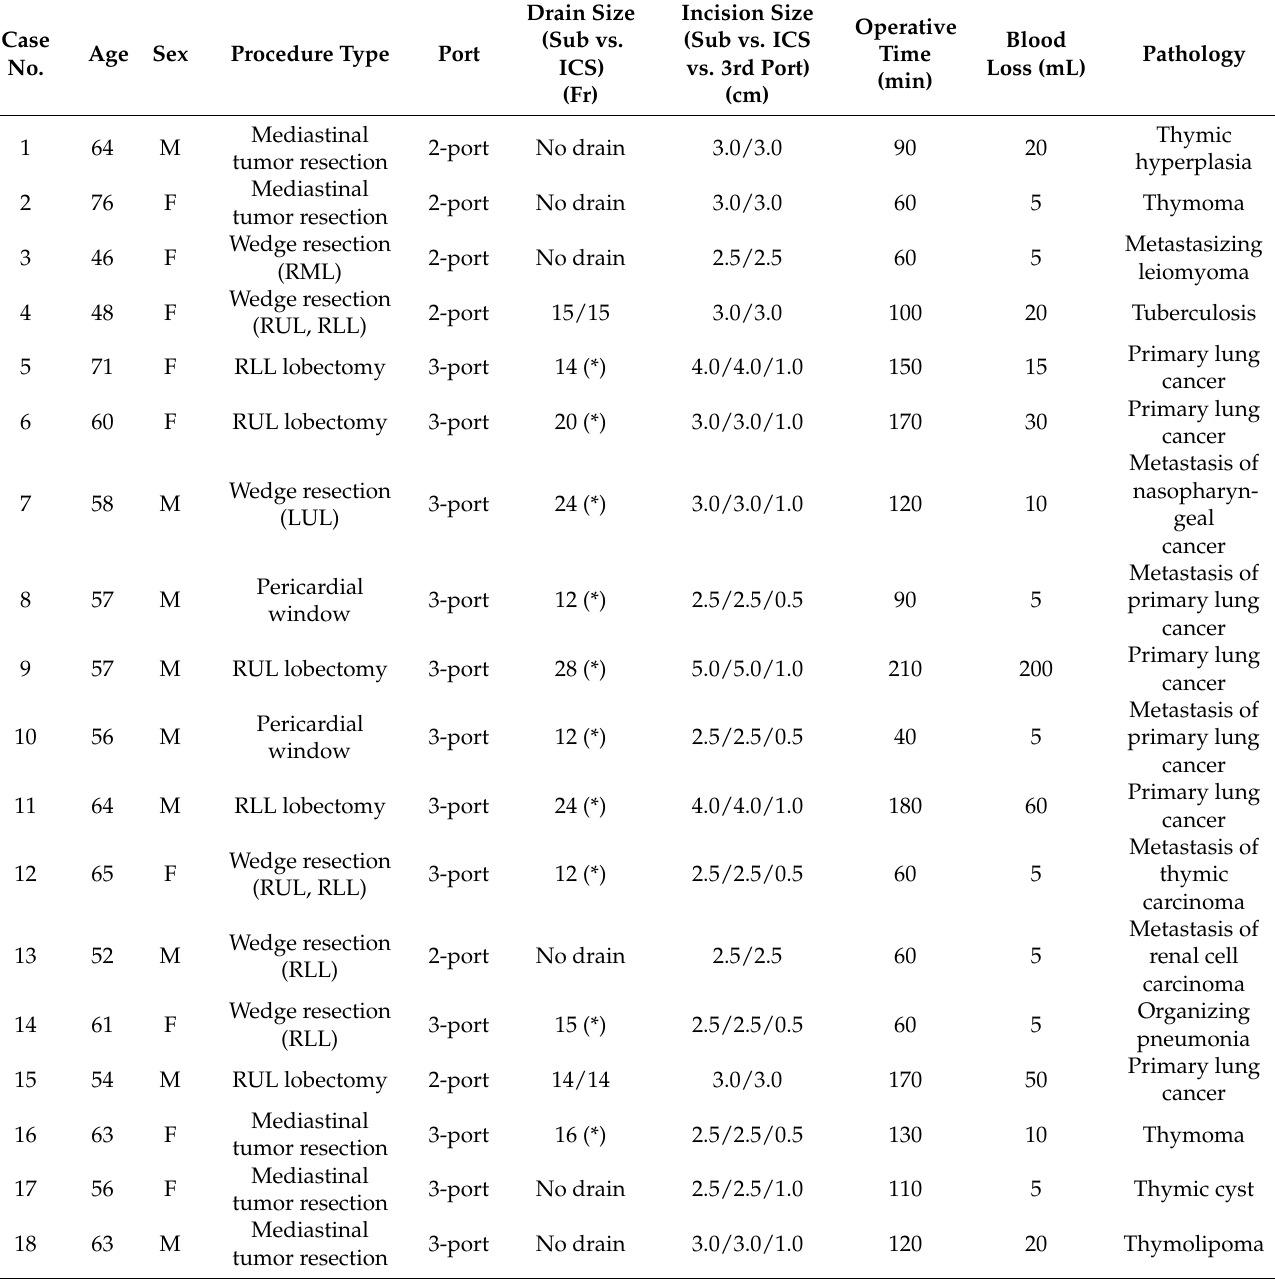
Table 2. Perioperative details of patients with unilateral VATS ( n =